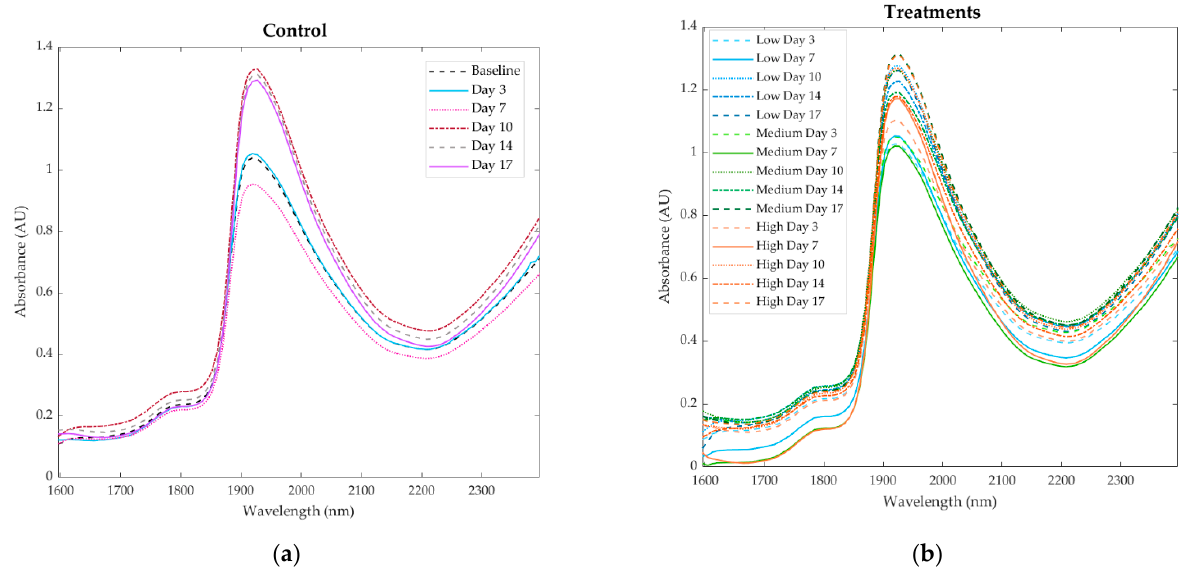
Figure 5. Near-infrared curves showing the absorbance values within the 1596–2396 nm wavelength range for ( a ) the control measurements and ( b ) the treatments (low, medium, high infestation) measured at different dates.